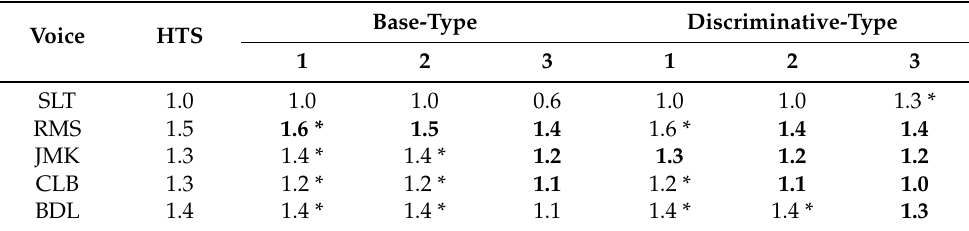
Table 3. PESQ Results for the hierarchical clustering levels. The higher values represent better results. * indicates the best result. In bold are the results which are not significantly different from the best, according to Tukey’s HSD